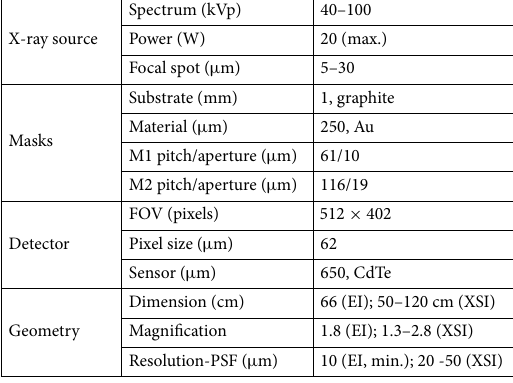
Table 1. PEPI Lab specifications.